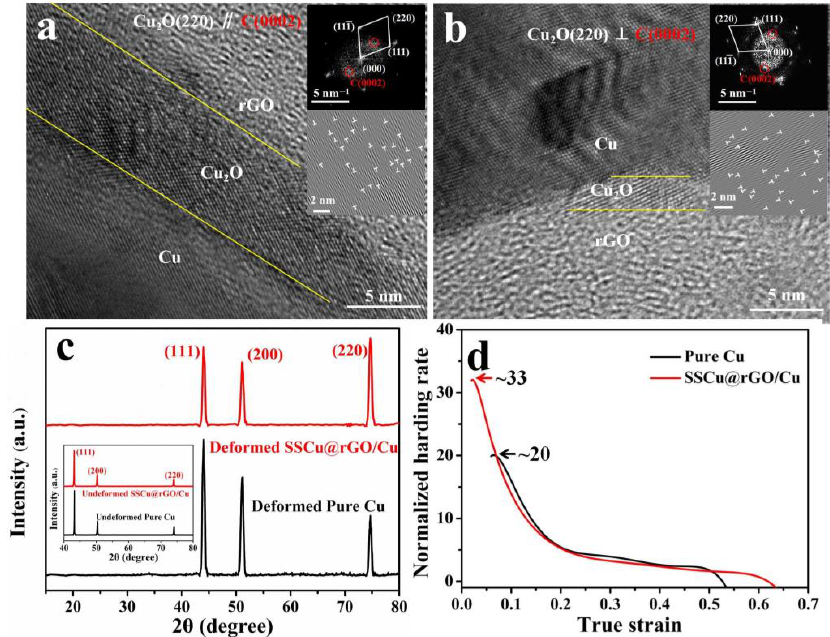
Figure 10. ( a , b ) Orientation relationship of the interface after deformation. ( c ) Comparison of the XRD patterns before deformation and perpendicular to the tensile direction after deformation. ( d ) Normalized curve of the strain-hardening rate vs. true strain. SSCu@rGO also leads to an increase in fracture energy during deformation. The details of these processes are shown in Figure 11: crack deflection [64], rGO debonding and pulling out, the formation of secondary cracks, and crack pinning [65].